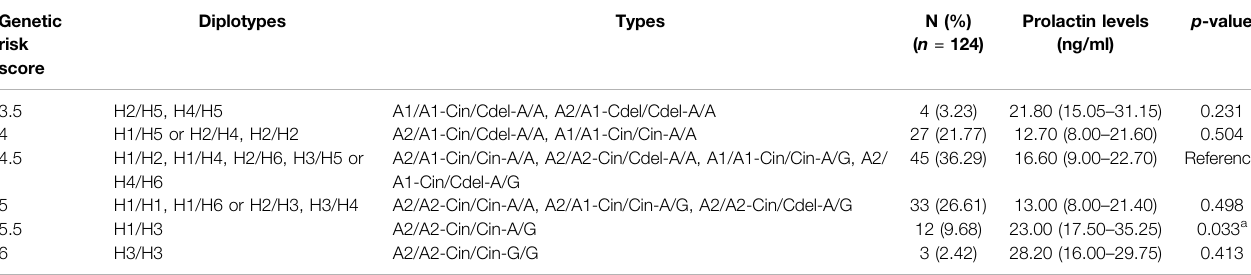
TABLE 4 | Associations between genetic risk scores for DRD2 gene haplotypes and serum prolactin levels. Genetic